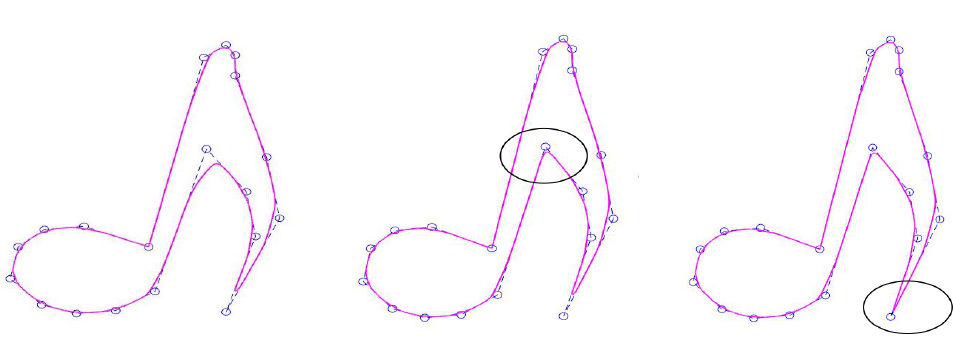
Figure 9. Close curves with uniform knot vector of the shape functions with α i ( t ) and β i ( t ) given in Equation